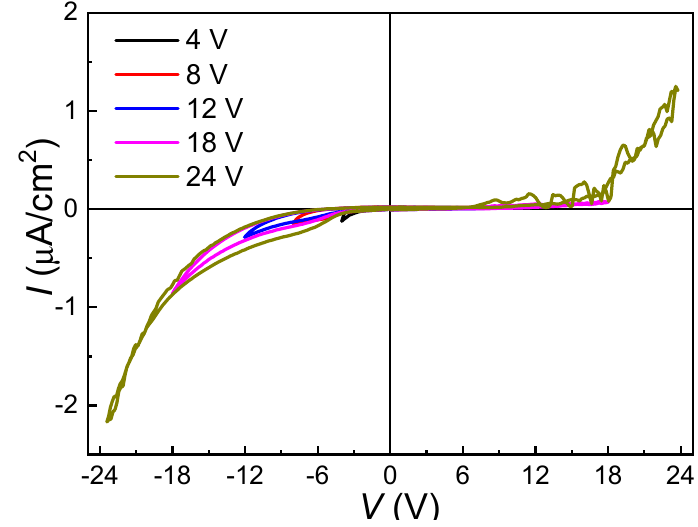
Figure 5. Room-temperature I - V curves of the (110)-oriented epitaxial BZT-BCT thin films.